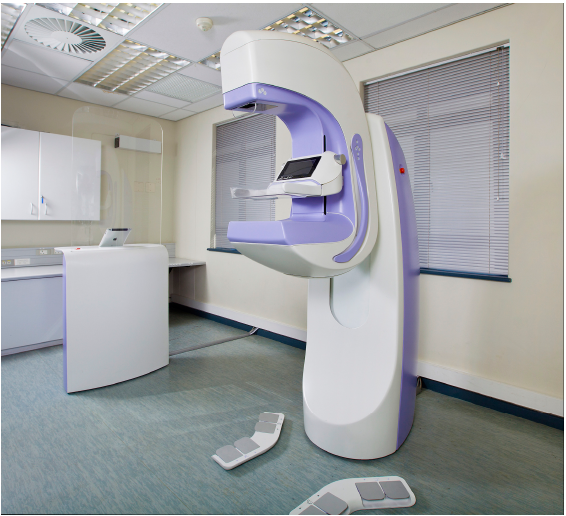
Figure 1. The Aceso dual-modality system as installed for the clinical trial, showing the acquisition workstation with iPad, a pair of foot pedals, gantry, and C-arm. workstation with iPad, a pair of foot pedals, gantry, and